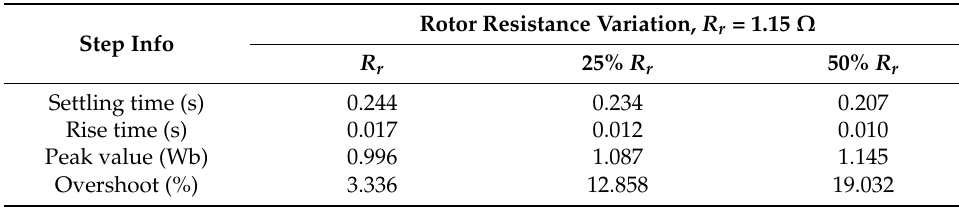
Table 2. Rotor flux performance under rotor resistance variation.